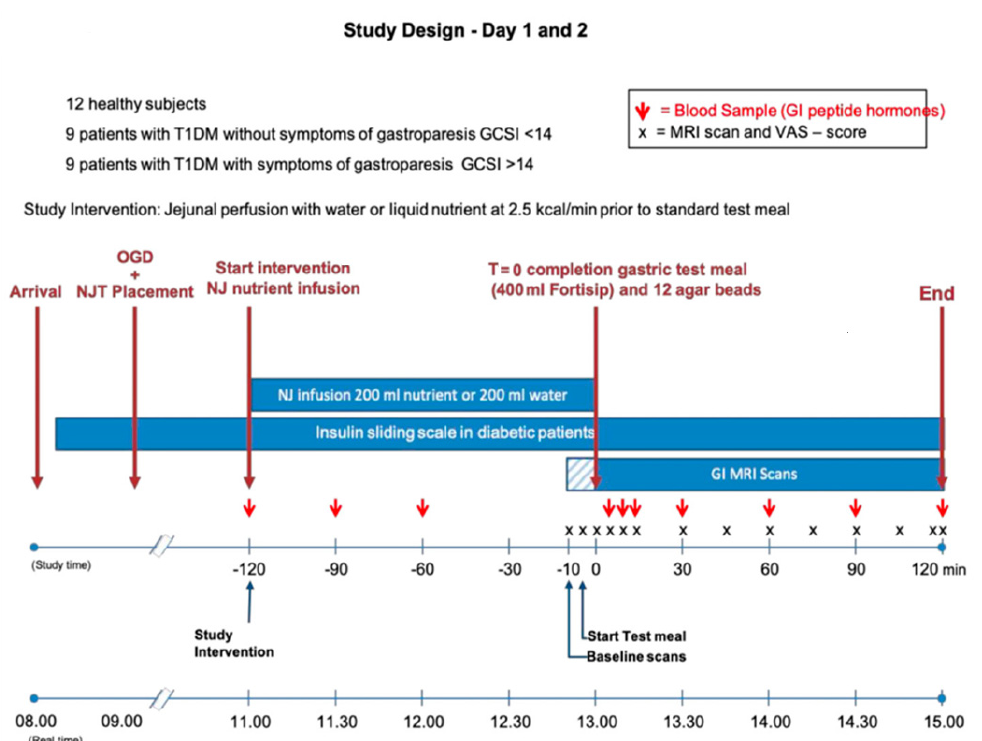
Figure 1. Study design with flow diagram detailing patient progress and procedures during the study. The NJT was placed under sedation during endoscopy. After 2 h recovery, the study intervention was delivered over 120 min. The oral meal was ingested over 10 min, and study measurements were acquired. NJT, naso-jejunal tube; M, meal; MRI, magnetic resonance imaging; OGD, Oesophago-Gastro-Duodenoscopy; GI, gastrointestinal; VAS, visual analogue scale, GCSI, gastroparesis cardinal symptom index.